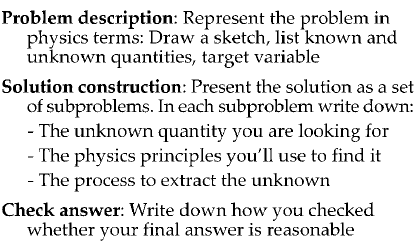
FIG. 4. Guidelines for presenting a problem solution according to a problem-solving